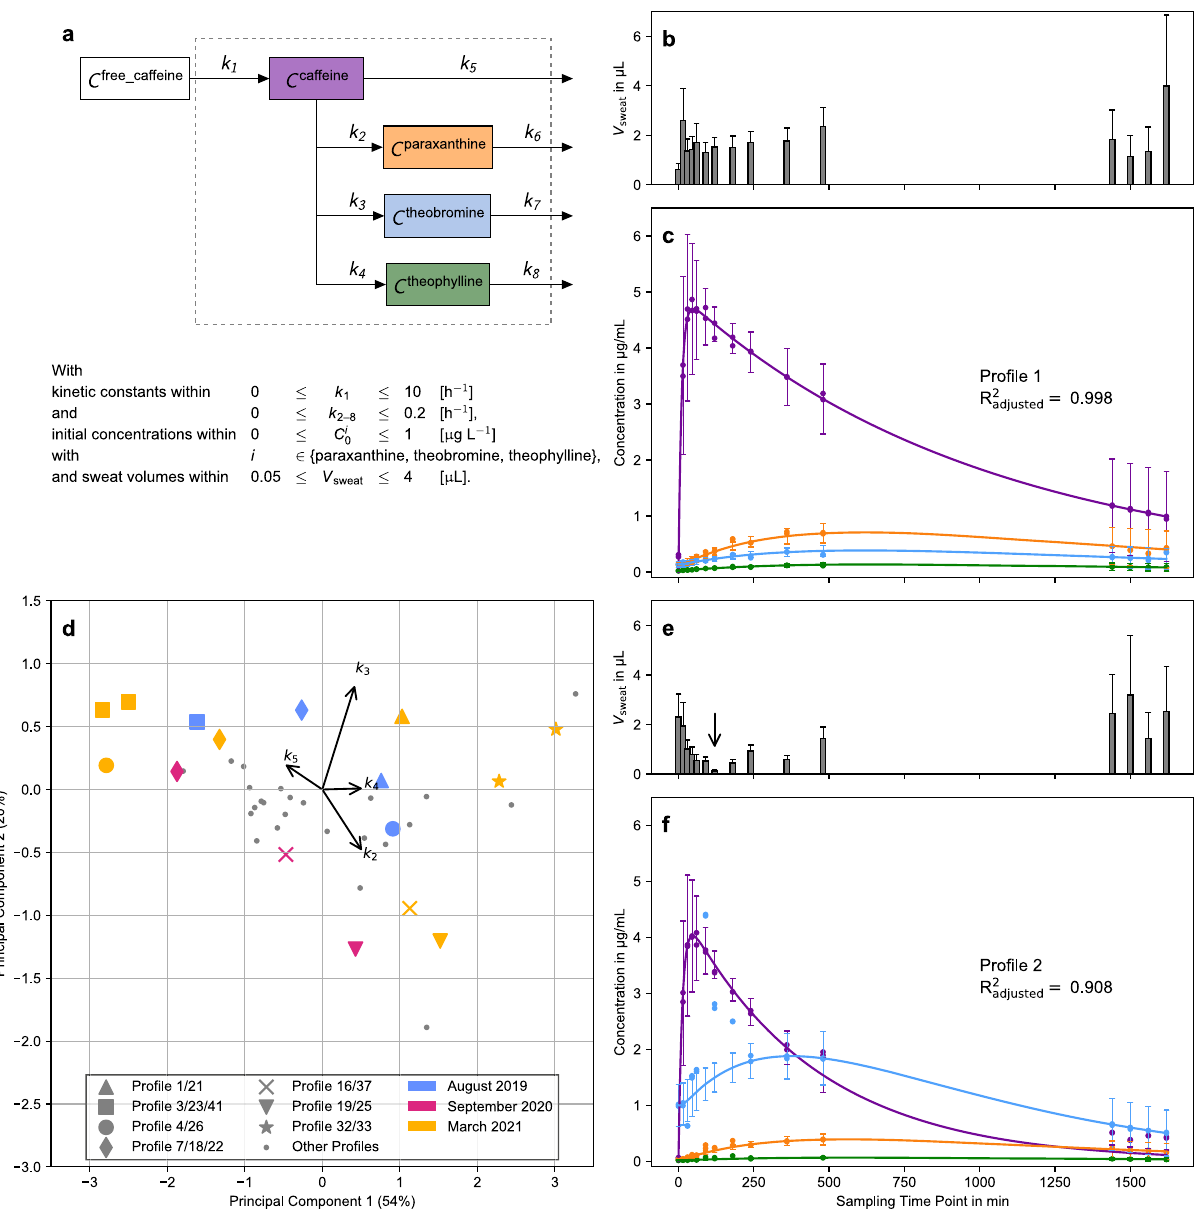
Fig. 5 Metabolic networks facilitate the discovery of dynamic metabolic patterns from individuals. a Network of caffeine and its major metabolites that was used for fi tting of the concentration time-series and the constraints of fi tting parameters. b , e Estimated sweat volumes ( V sweat ) in µ L of the measurements of volunteer pro fi les 1 and 2, respectively. Each bar represents a single V sweat . The error bars show the 95% con fi dence intervals of the model prediction. c , f Fitted concentration time-series of caffeine, paraxanthine, theobromine and theophylline for volunteer pro fi les 1 and 2 (compare Fig. 4d). The lines refer to the fi tted concentration and the symbols refer to the measured values ( e M ) divided by V sweat at each time-point (Eq. (1)). The error bars show the 95% con fi dence intervals of the model predictio n ( n = 2 technical replicates times 4 metabolites times 15 time-points per pro fi le). The arrow marks the sweat volume of pro fi le 2 at 120 min (see text). A visual representation of the in fl uence of the sweat volume on the fi t is shown in Supplementary Fig. 7. d Two-dimensional PCA plot of the fi tted caffeine conversion constants. Volunteer pro fi les (i.e. time-series) from the same participant are plotted with large, coloured symbols whereas participants who contributed only once are marked with small grey circles. The colours represent the month of